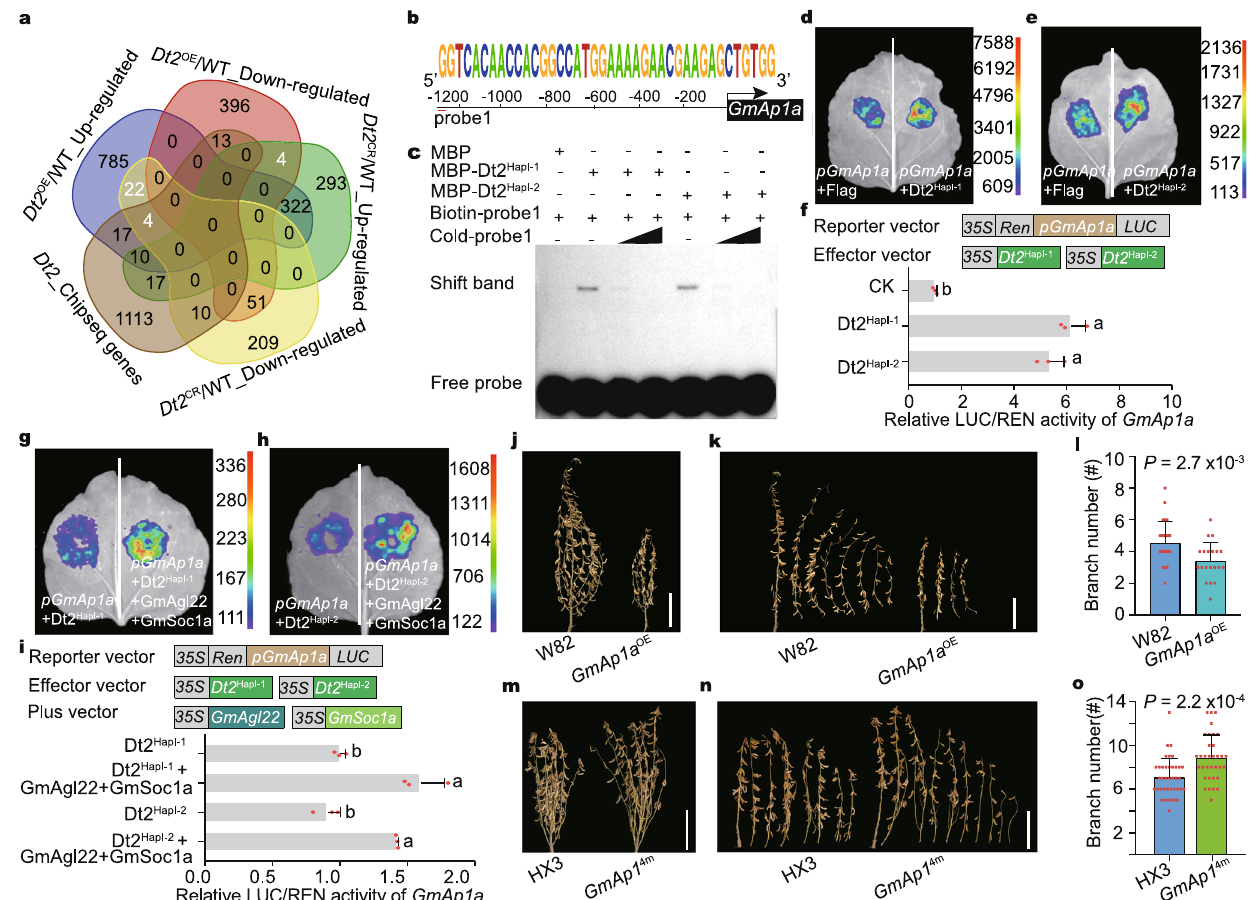
Fig. 4 | Dt2directlybindsthe promoter ofGmAp1aand positively regulates its expression. a Venn diagram among overlapping DEGs from DN50, Dt2 CR and Dt2 OE lines. b A probe sequence that could be bound by the MADS-box protein in the promoter of the GmAp1a is predicted in Plantpan (http://plantpan.itps.ncku. edu.tw/). c MBP-Dt2 HapI-1 orMBP-Dt2 HapI-2 directlybindtothepromoterof GmAp1a in EMSA. MBP, maltose-binding protein. At least 3 independent replicates are per- formed and a representative result is shown. d , e Transient dual luciferase (dual- LUC) assays of Dt2 HapI-1 ( d ) and Dt2 HapI-2 ( e ) binding to the promoter of GmAp1a in tobacco leaves. f Transient dual luciferase (dual-LUC) assay of Dt2 on the pro- moter of GmAp1a in Arabidopsis protoplast ( n =3 biologically independent repli- cates). Different letters indicate statistically signi fi cant differences at P <0.05 by one-way ANOVA test. g , h Transient dual-LUC assay in tobacco leaves of Dt2 HapI-1